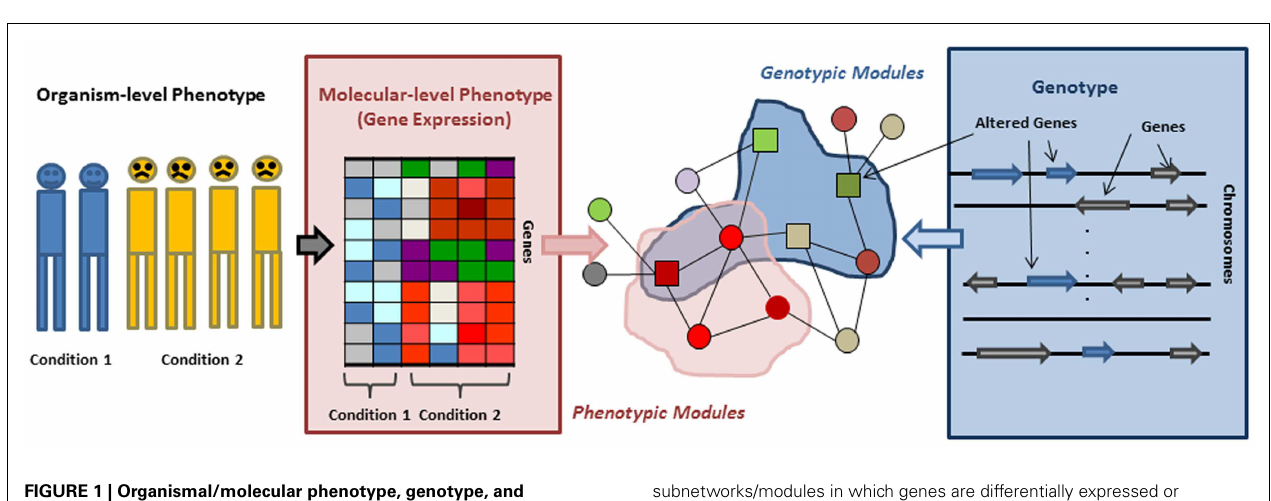
FIGURE 1 | Organismal/molecular phenotype, genotype, and genotypic/phenotypic modules. Phenotypic modules can be identified by overlaying gene expression on an interaction network and searching for